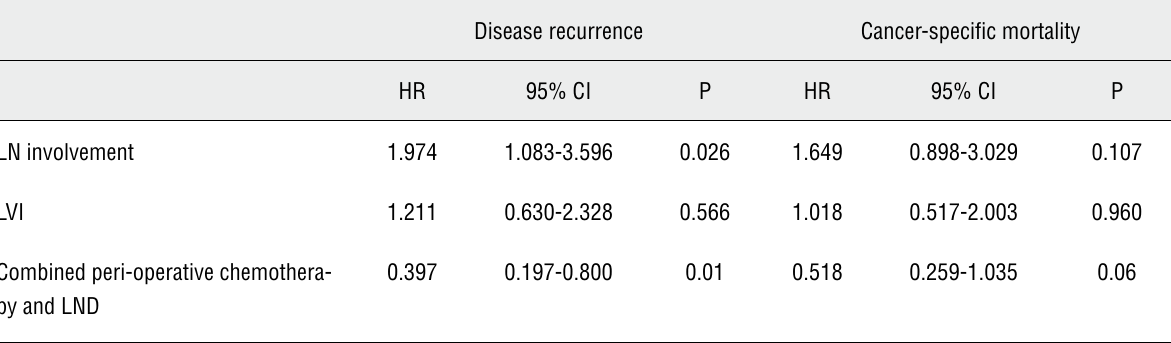
Table 2 - Multivariable Cox Regression analysis addressing disease recurrence and cancer specific mortality in 69 T4 uTuC patients treated with